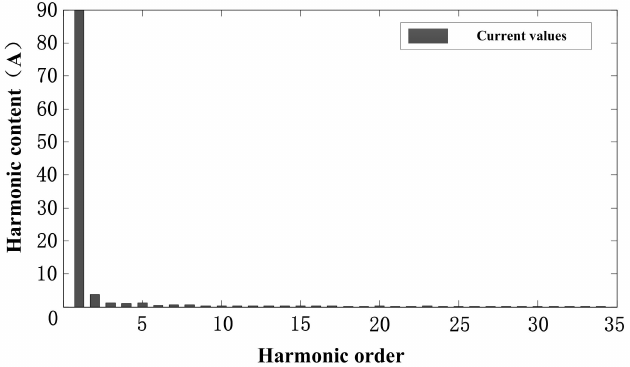
Figure 13. The low-order current harmonics of RSC in super-synchronous state.